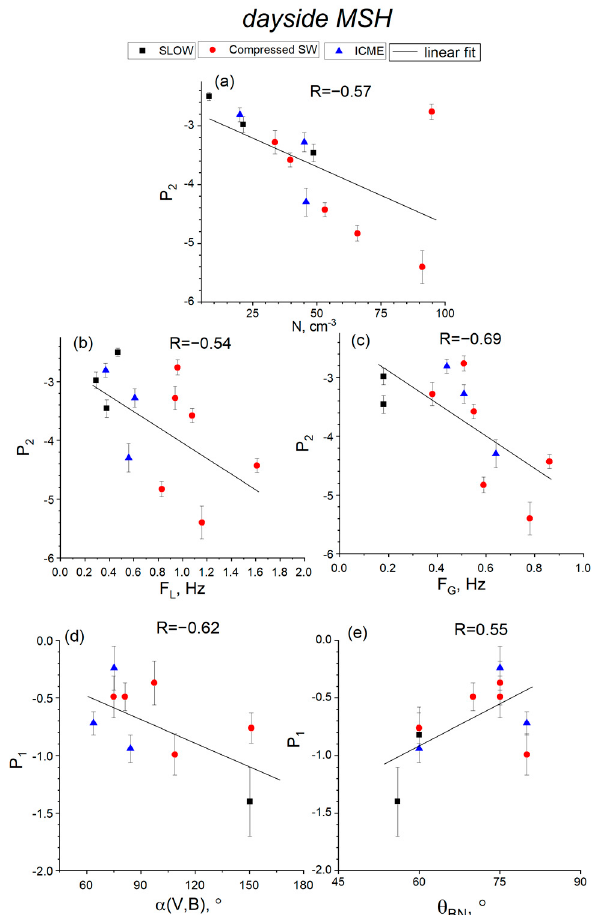
Figure 7. Slope P 2 at the kinetic scales in the dayside MSH vs. ion density ( a ), inertial length frequency F L ( b ), gyrostructure frequency F G ( c ); slope P 1 at the MHD scales in the dayside MSH vs. angle between V and B vectors ( d ), θ BN angle ( e ).